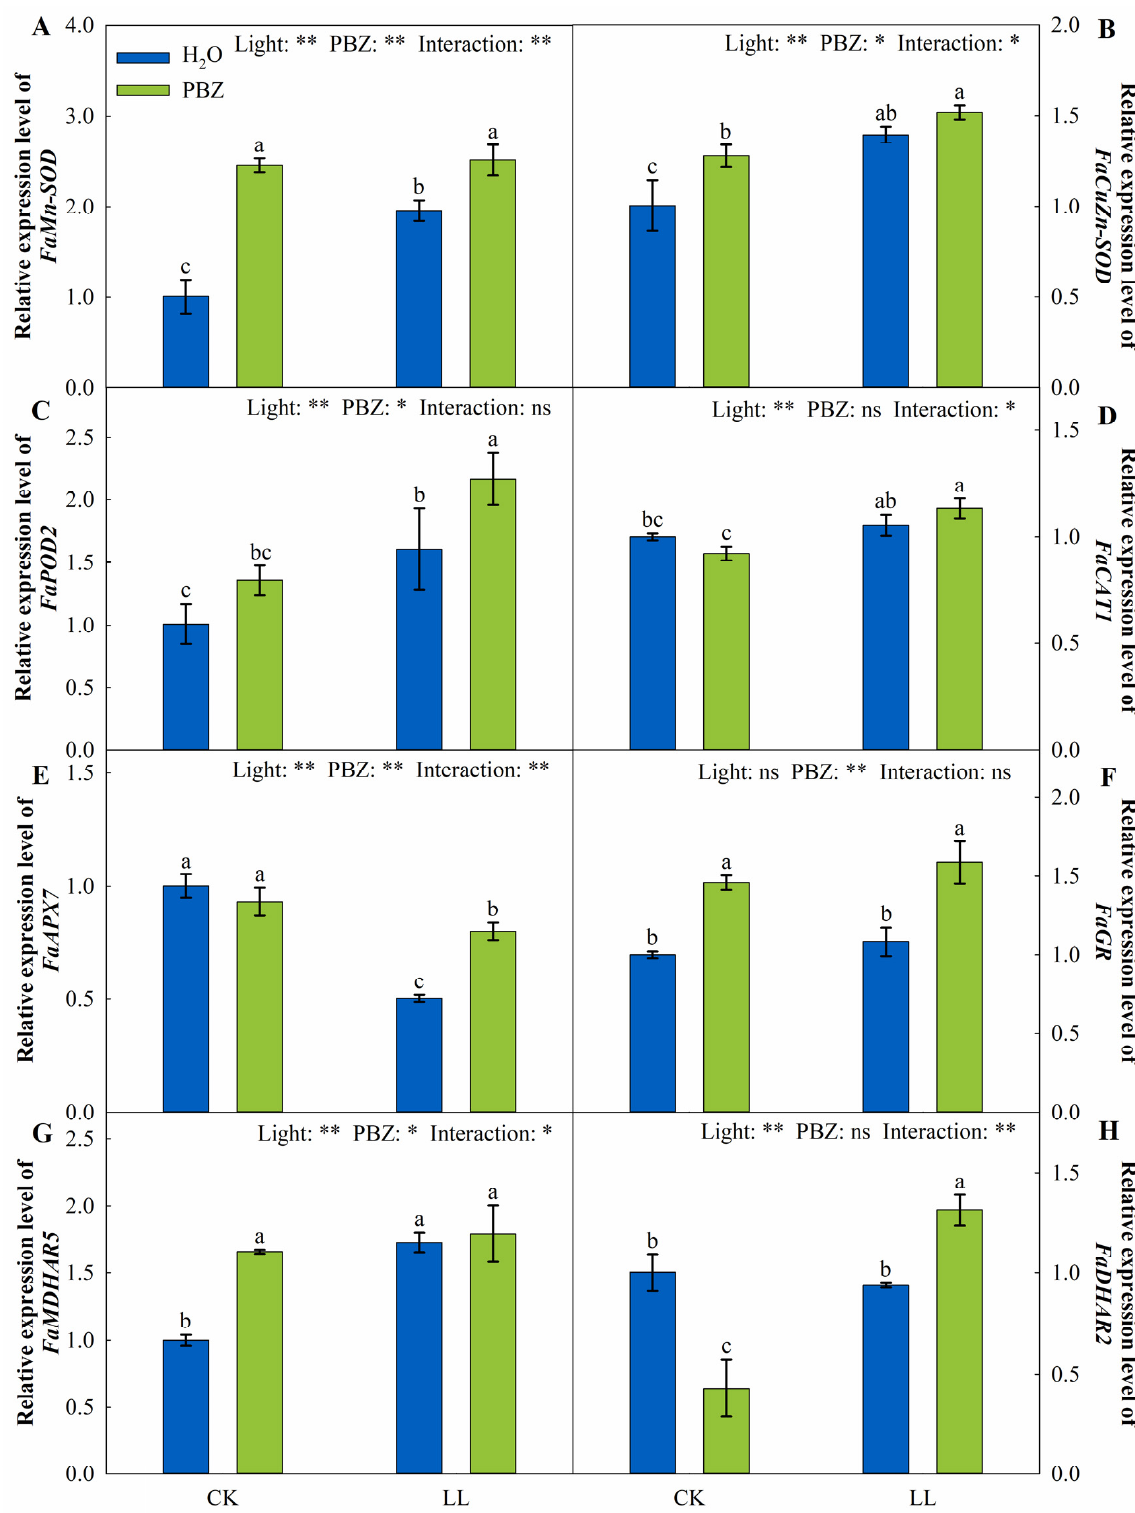
Figure 6. The expression level of genes encoding antioxidant enzymes of tall fescue leaves induced by paclobutrazol under control (CK) and LL stress. ( A ) FaMn-SOD , ( B ) FaCuZn-SOD , ( C ) FaPOD2 , ( D ) FaCAT1 , ( E ) FaAPX7 , ( F ) FaGR , ( G ) FaMDHAR5 , and ( H ) FaDHAR2 . * and ** indicate significant differences at p < 0.05 and p < 0.01, respectively. ns indicates not significant. Different letters above the vertical bars indicate significant differences at p < 0.05 according to Duncan’s multiple range test.